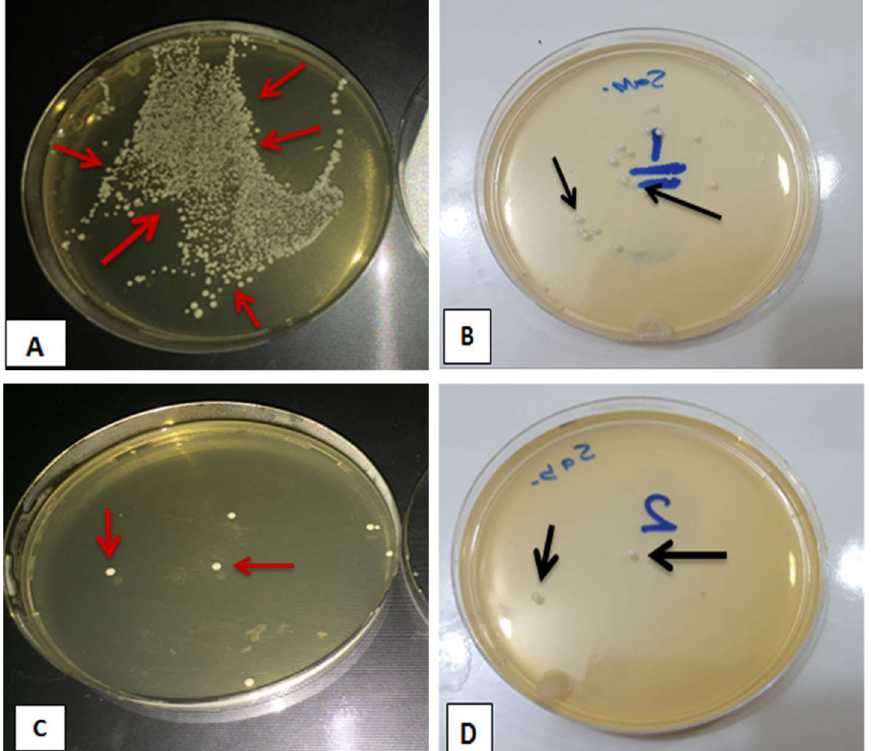
Figure 8. SDA plates showing CFU/mL of C. albicans for each group of study: ( A ) control with a large number of fungal colonies compared with the nanocomposites with different TiO 2 NPs concentrations showing a decreased number of colonies: ( B ) 1.0 wt.% ( C ) 1.5%, and ( D ) 2.0 wt.%.